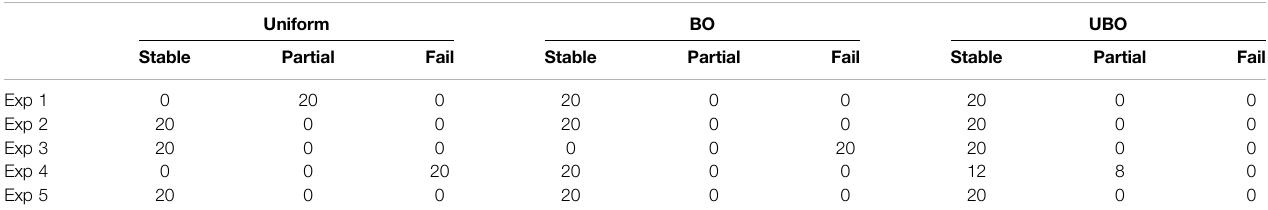
TABLE 3 | Frequency distribution of experiments on bottle to evaluate grasp stability. Uniform BO UBO Stable Partial Fail Stable Partial Fail Stable